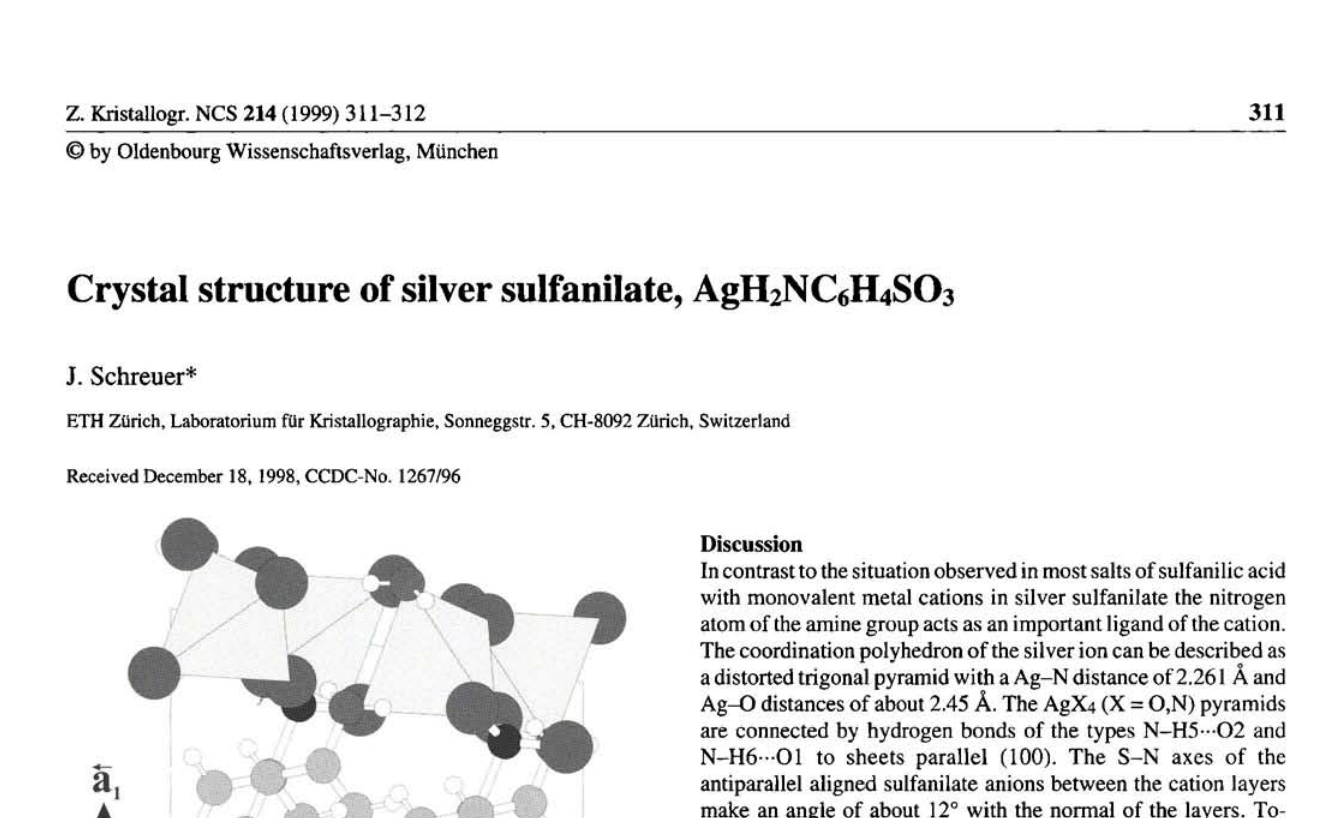
Table 1. Data collection and handling. Crystal: